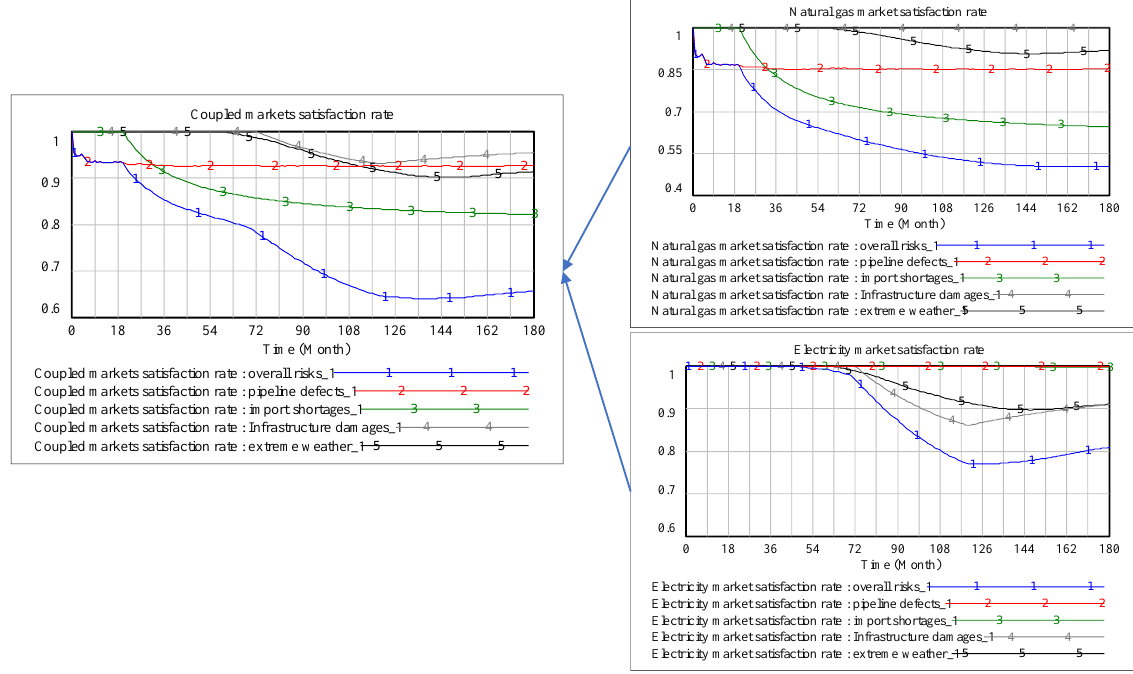
Figure 5. Dynamic behavior of the key variables, considering multiple risks and dual interactions.